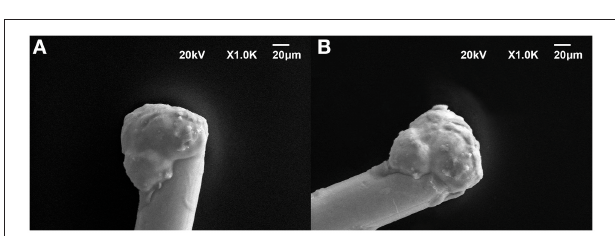
FIGURE 4 | Representative SEM micrographs of the same pHEMA-encapsulated PEDOT-PSS-CNT microsphere (A) before and (B) after one week immersion in a PBS solution containing 30 mM of H 2 O 2 to mimick the situation where the device is implanted in the human body and hydrogen peroxide is generated by an inflammatory reaction.